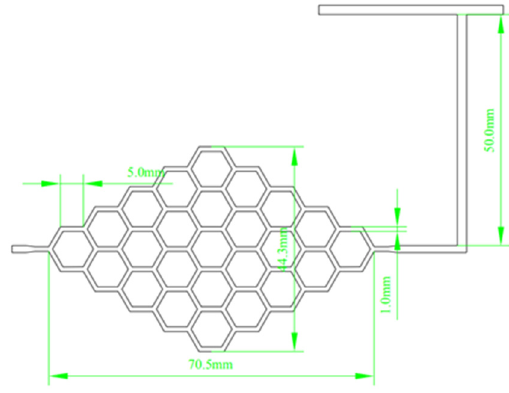
Figure 1. Honeycomb structure of the microreactor used.